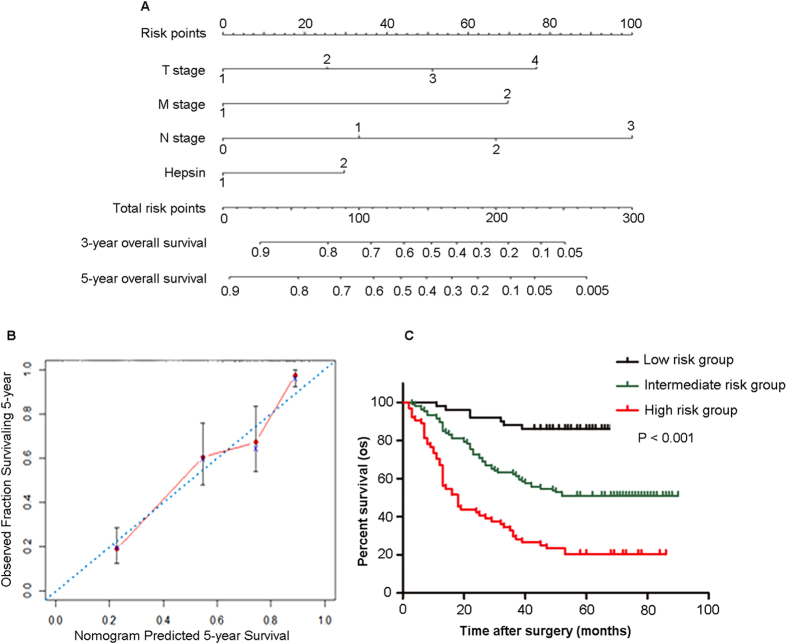
Nomogram and calibration plot analyses for the predictive value of hepsin protein expression in gastric cancer patients.(A) Nomogram generation for predicting overall survival integrated with T stage (1 represents T1, 2 represents T2, 3 represents T3, 4 represents T4), N stage (0 represents N0, 1 represents N1, 2 represents N2, 3 represents N3), distant metastasis (0 represents absence, 1 represents presence), and hepsin expression (0 represents low expression, 1 represents high expression). (B) Calibration curve for nomogram-predicted and observed 5-year overall survival. (C) The patients were stratified into 3 groups according to their percentile of the nomogram-predicted score: low risk group (<25th percentile), intermediate risk group (25th–75th percentile), and high risk group (>75th percentile).